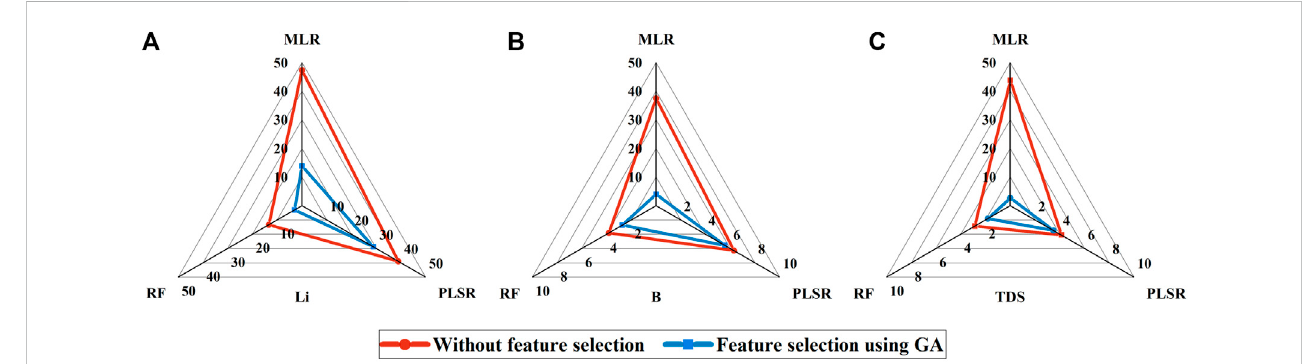
FIGURE 11 Radar plot of MAPE on the testing set of the three models. (A – C) are the model results for estimated Li, B, and TDS contents, respectively.